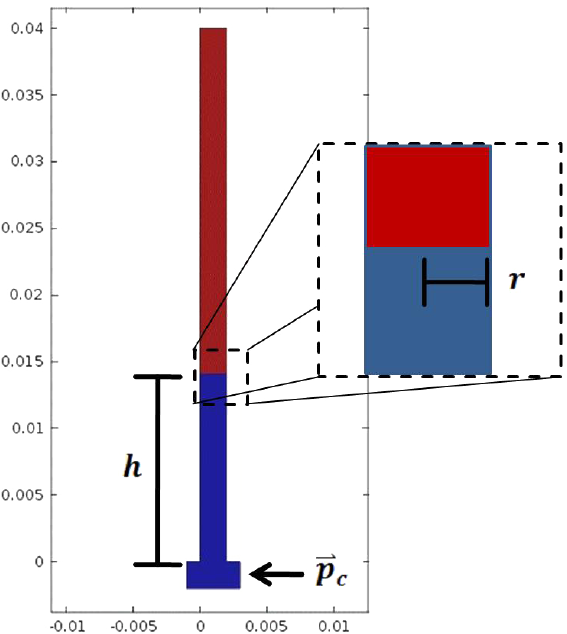
Figure 5. Model set-up for the model validation via Young-Laplace capillary rise at pressure equilibrium. Blue and red colours define water and air respectively. Height of water column is h at a capillary radius r and an inlet capillary pressure p c . Orientation axes values are given in metres.